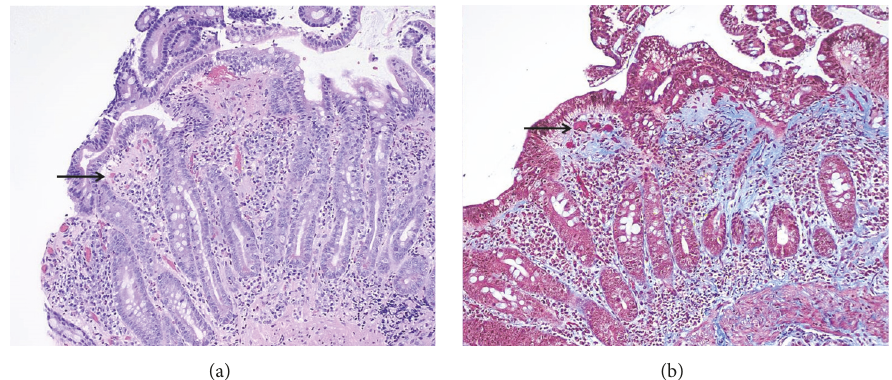
Figure 3: 20x magnification: (a) hematoxylin and eosin-stained section of the duodenum shows villous shortening/partial atrophy with increased subepithelial collagen deposition (pink). (b) Trichrome stain highlights the collagen blue. Arrows indicate entrapped capillaries.